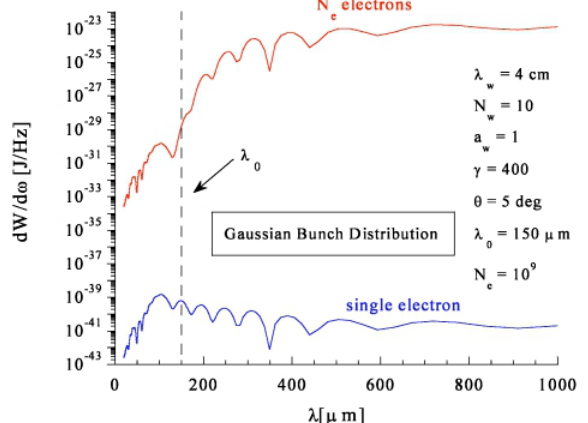
FIG. 5. (Color) Effects of near-field effects on the energy spectrum for a single electron. The detector distance is 0.5 m.